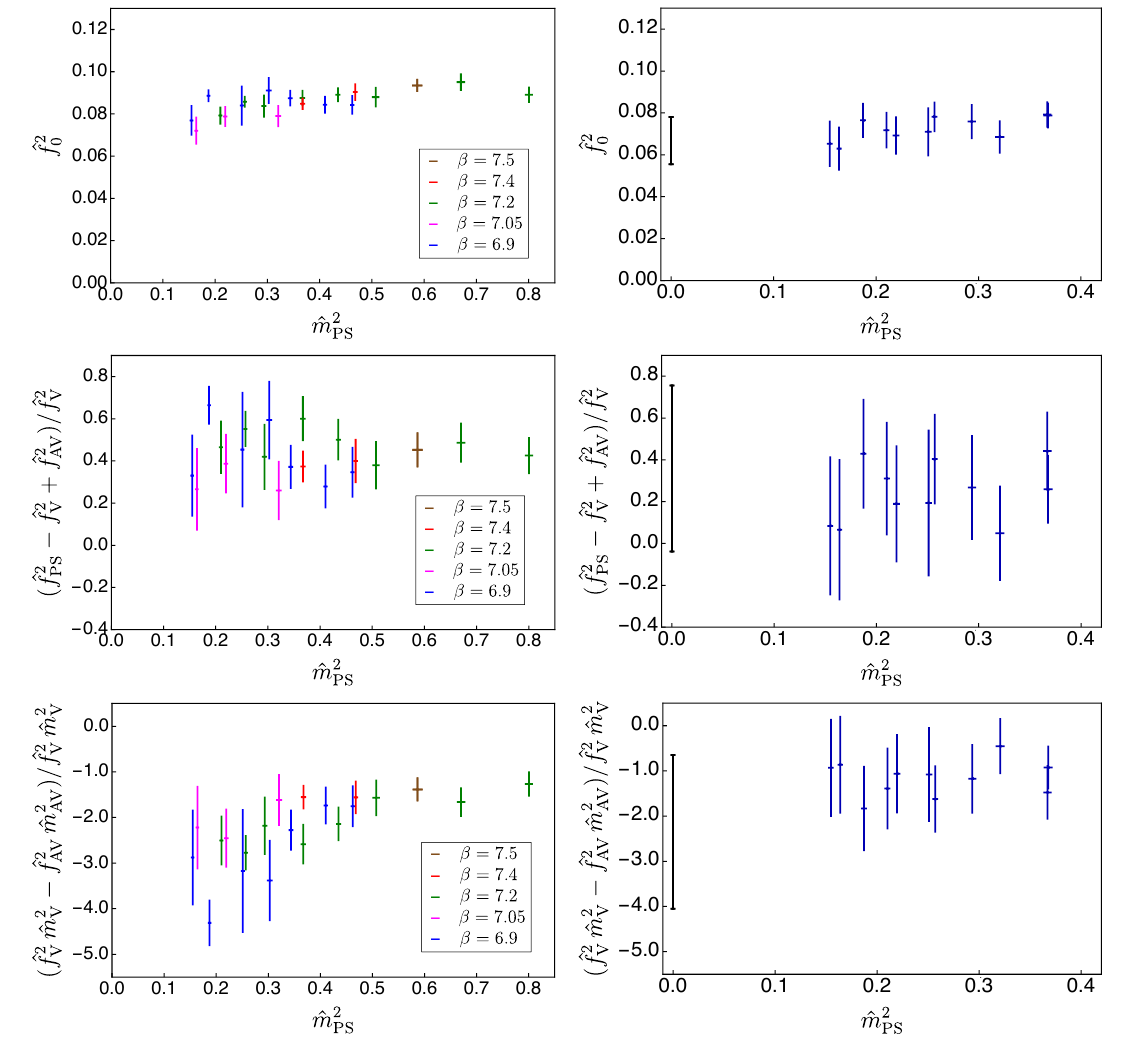
Figure 15. Top to bottom: ^ f 2 , the (cid:12)rst, and the second Weinberg sum rule, saturated over 0 the lightest spin-1 states, as a function of ^ m 2 . Left panels: we do not perform the continuum PS extrapolation, colour coding represents the bare lattice coupling of the various ensembles. Blue, purple, green, red and brown colours have (cid:12) = 6 : 9, 7 : 05, 7 : 2, 7 : 4 and 7 : 5, respectively. Right panels: continuum-extrapolation results as in table 9 (in blue), and the results of the continuum and massless extrapolation (in black). Statistical and systematic errors are summed in quadrature.